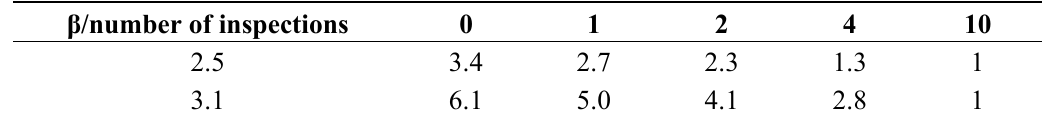
Table 18. Required FDF values for minimum cumulative reliability level. SN-curve: “With cathodic protection”. Close visual inspection.